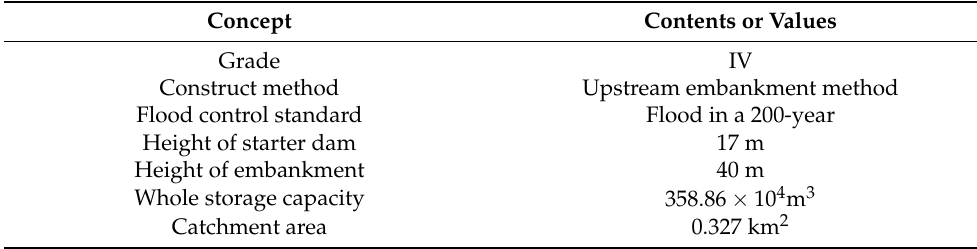
Table 1. Characteristics of the Dagangding tailings dam.